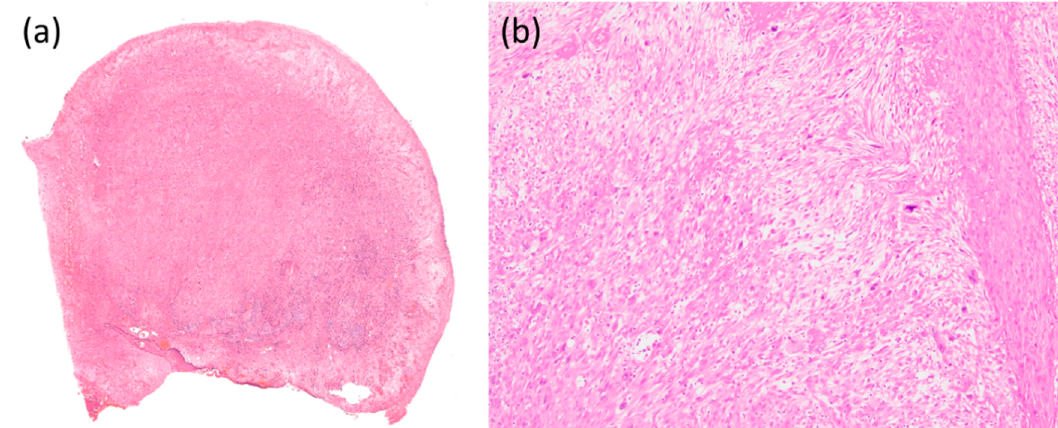
Figure 4. Histological findings of the tumor. ( a ) The tumor showed an exophytic mass with an ulcerated surface. ( b ) The tumor was mainly composed of spindle cells and a few atypical epithelial cells (100×).